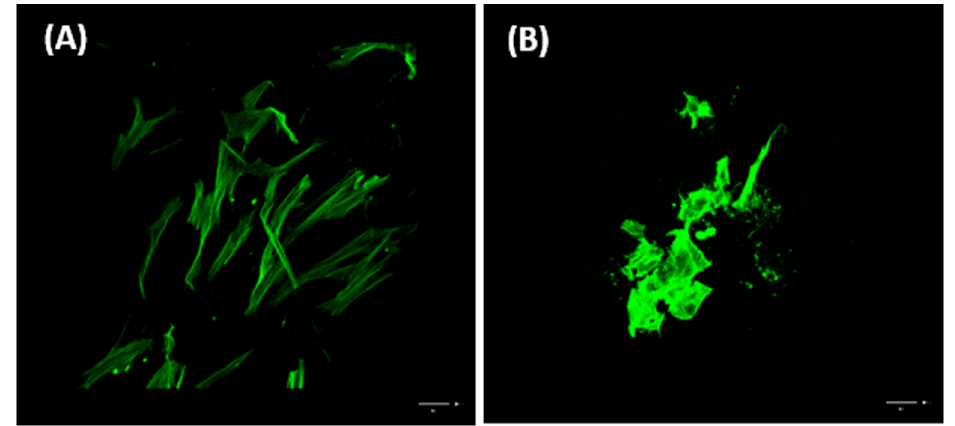
Figure 9. HFFF2 cells growing for 7 days in culture on 10 kGy, N 2 bubbled, 5% PVP membranes ( B ) display a different morphology and a very dense actin cytoskeletal organization, as compared to control cells growing on the polystyrene surface of the wells ( A ) but are able to invade the depth of the membrane (green: actin staining; scale bar 50 μ m).